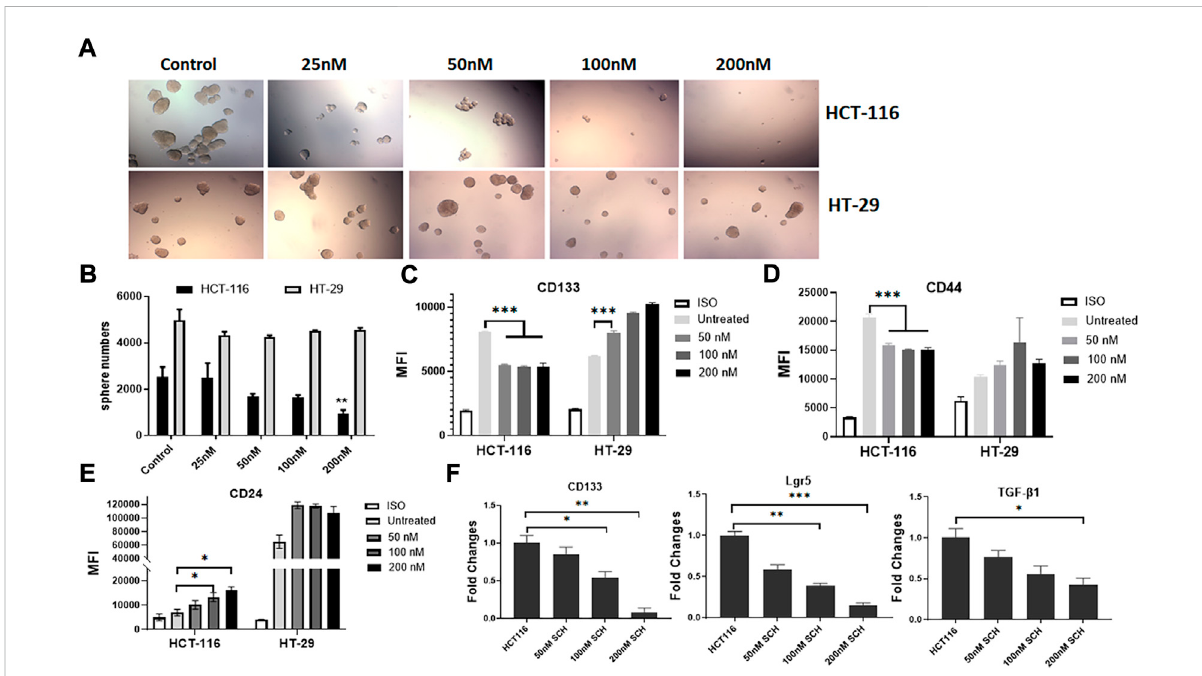
FIGURE 3 Inhibition of ERK by SCH772984 suppresses the spheroid formation and stemness in HCT-116 but not in HT-29 cells. The photos show the morphology and numbers of tumor spheroids from HCT-116 and HT-29 cells after SCH772984 (SCH) treatment at different doses (A) . A dose- dependent inhibition of sphere formation and growth in HCT-116 cells can be seen, comparing to that in HT-29 cells. (B) , the number of spheroids was signi fi cantly decreased in HCT-116 cells at the 200 nM dose, but not in HT-29 cells. Flow cytometry analysis showed surface marker expressions ofCD133 (C) andCD44 (D) decreasedindose-dependentmannersatthedosesof50,100,and 200 nMinHCT-116, thoughthere wasa slight increase for CD24 (E) . Inversely, the expressions of these markers increased (C, D, E) in HT-29 cells after SCH772984 treatment. (F) , the stem geneexpressionsofCD133,Lgr5,andTGF- β inHCT-116cells,theyalldisplayedadose-dependentdecreaseafterSCH772984treatment.*: p < 0.05; **: p < 0.01; ***: p <